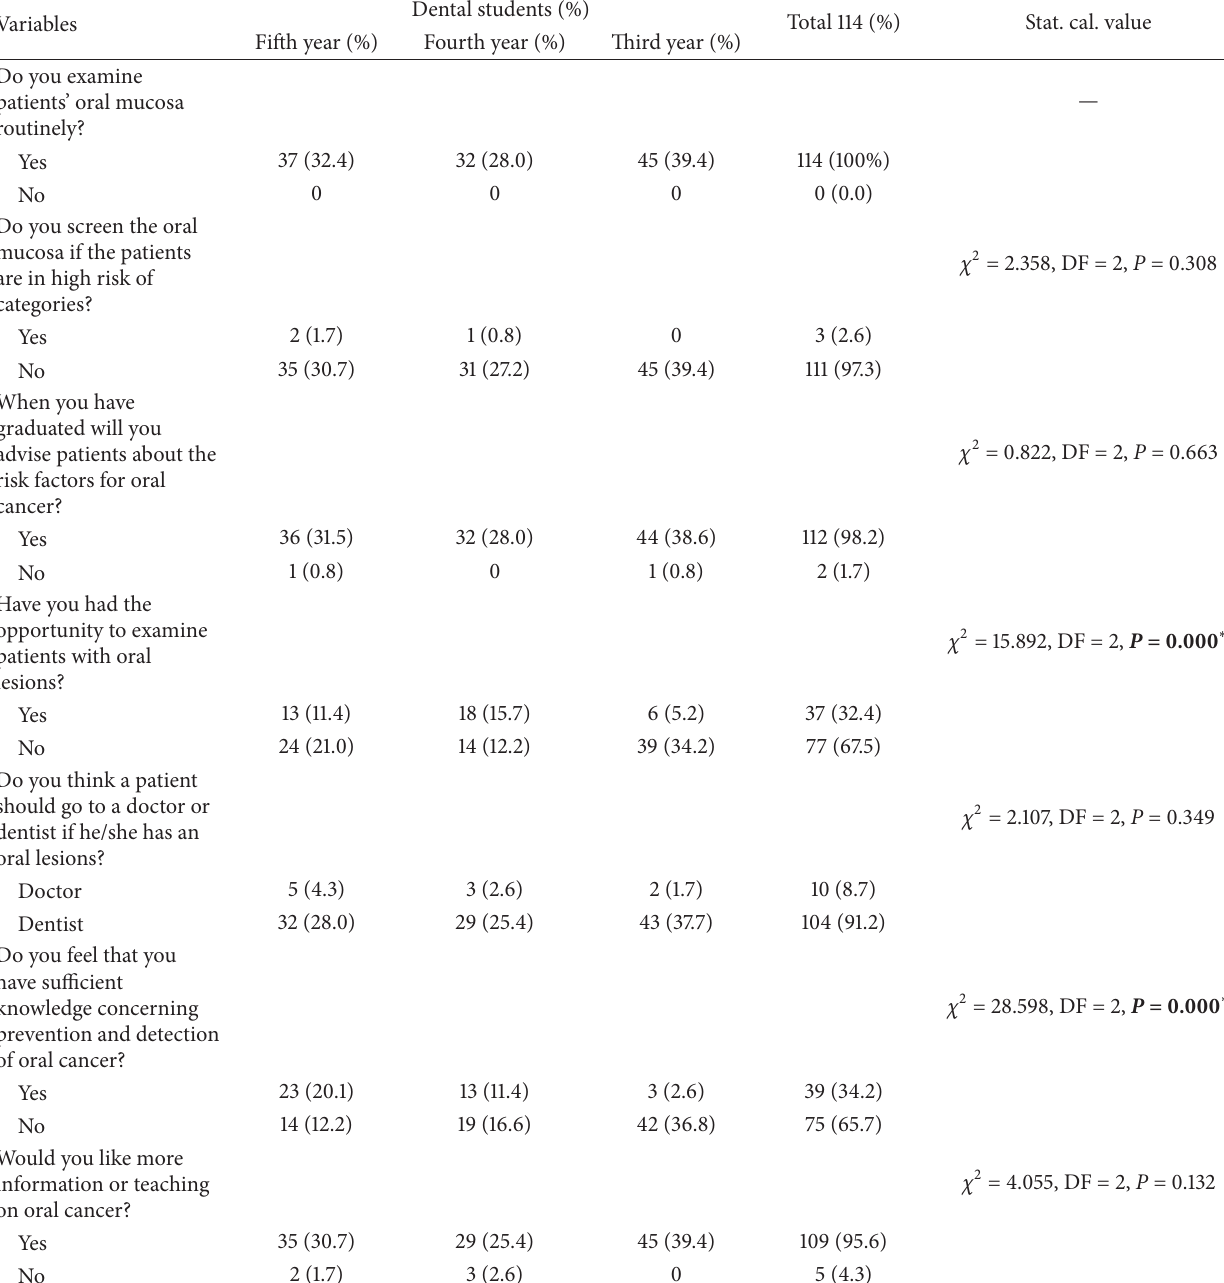
Table 2: Level of knowledge of participants on oral